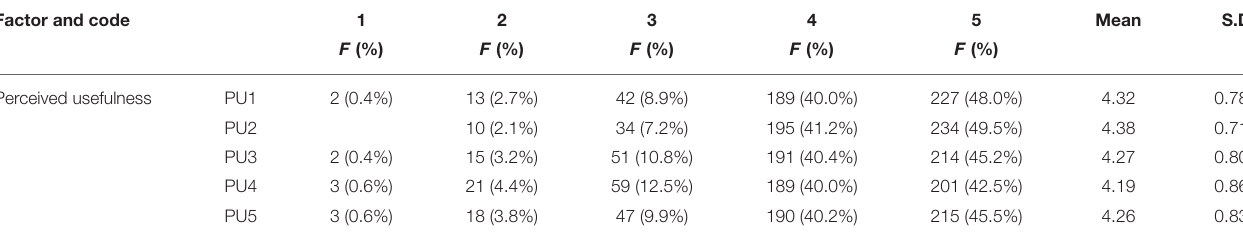
TABLE 10 | Measuring perceived usefulness